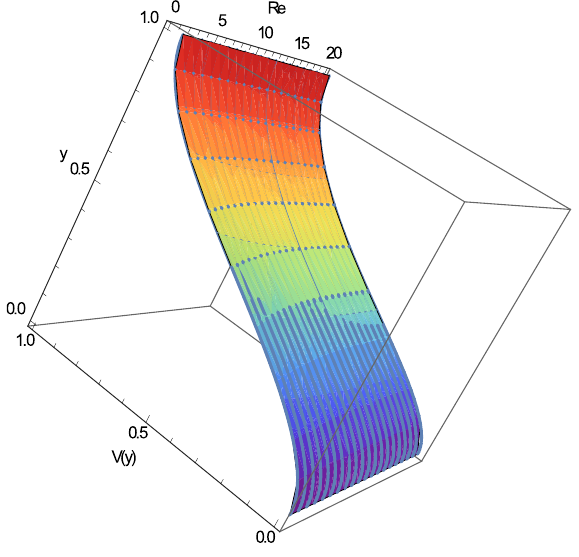
Figure 4. The effect of the increase of Re on V for the case Ha = 0—three dimensional